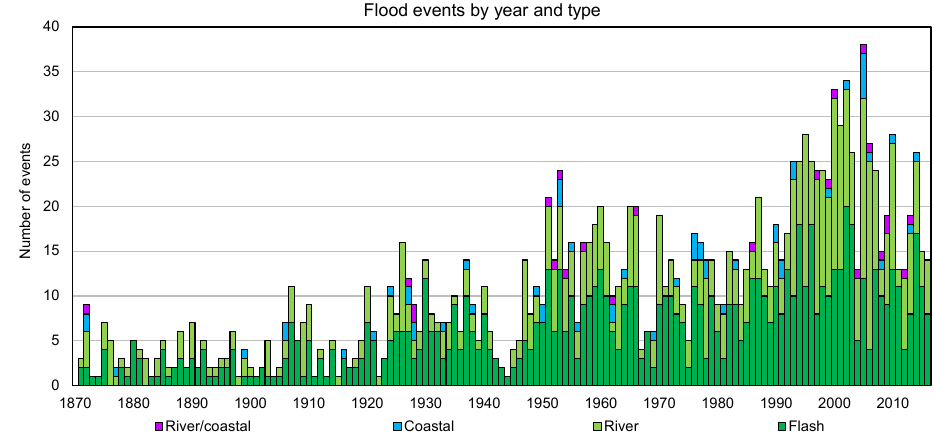
Figure 4. Distribution of flood events in HANZE by year and type.